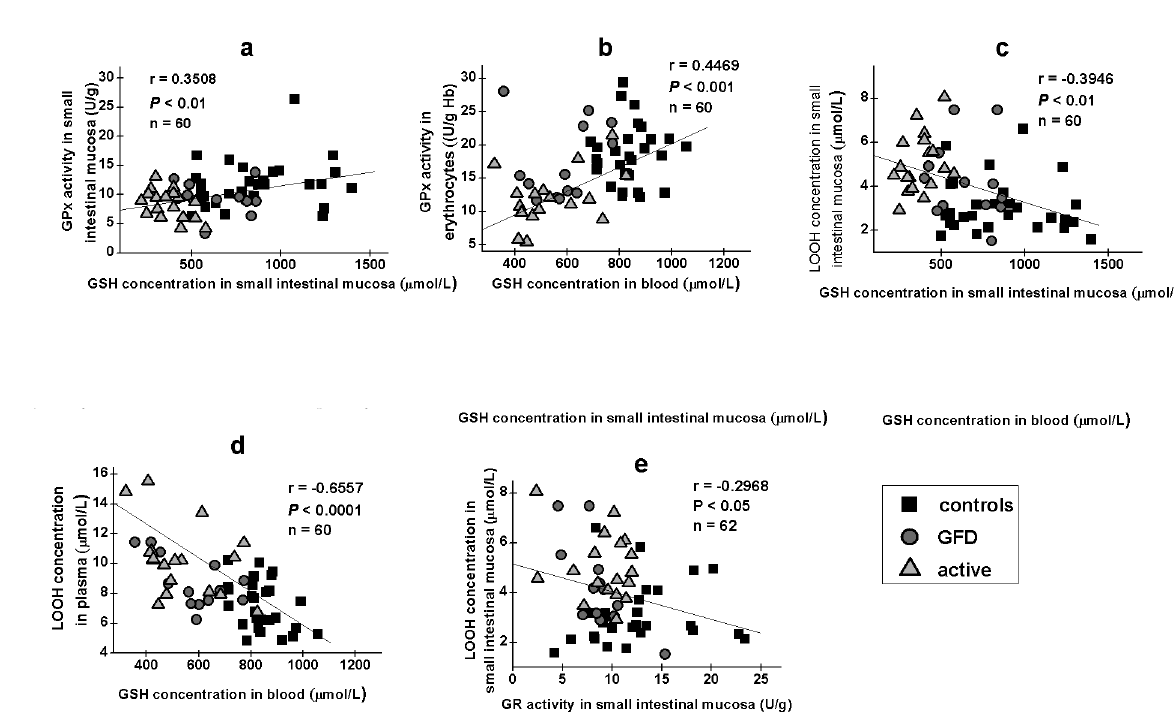
Figure 2. Data plot and coefficients of Pearson’s product moment correlation r between the GSH concentration and the GPx activitiy in small intestinal mucosa (a) and peripheral blood (b), the GSH concentration and the LOOH concentration in small intestinal mucosa (c) and peripheral blood (d), and the GR activity and the LOOH concentration in small intestinal mucosa (e) of control subjects, patients on gluten-free diet (GFD) and patients with the active form of the celiac